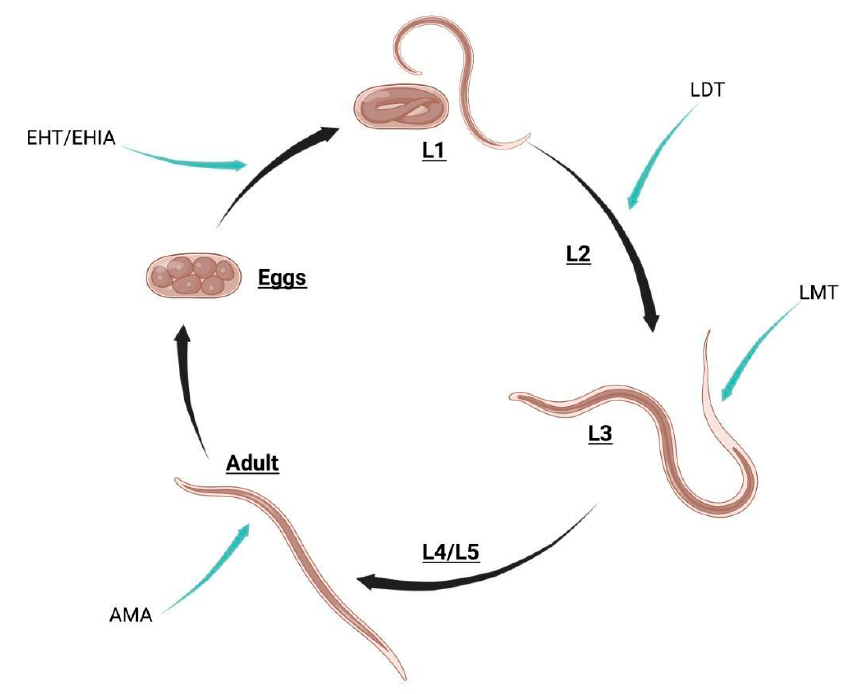
Figure 4. Anthelmintic evaluation throughout the parasite life cycle. L1 to L5 refer to larval stages. EHT/EHIA: Eggs Hatching Test/Eggs Hatching Inhibition Assay, LTD: Larval Development Test, LMT: Larval Motility Test, AMA: Adult Motility Assay.